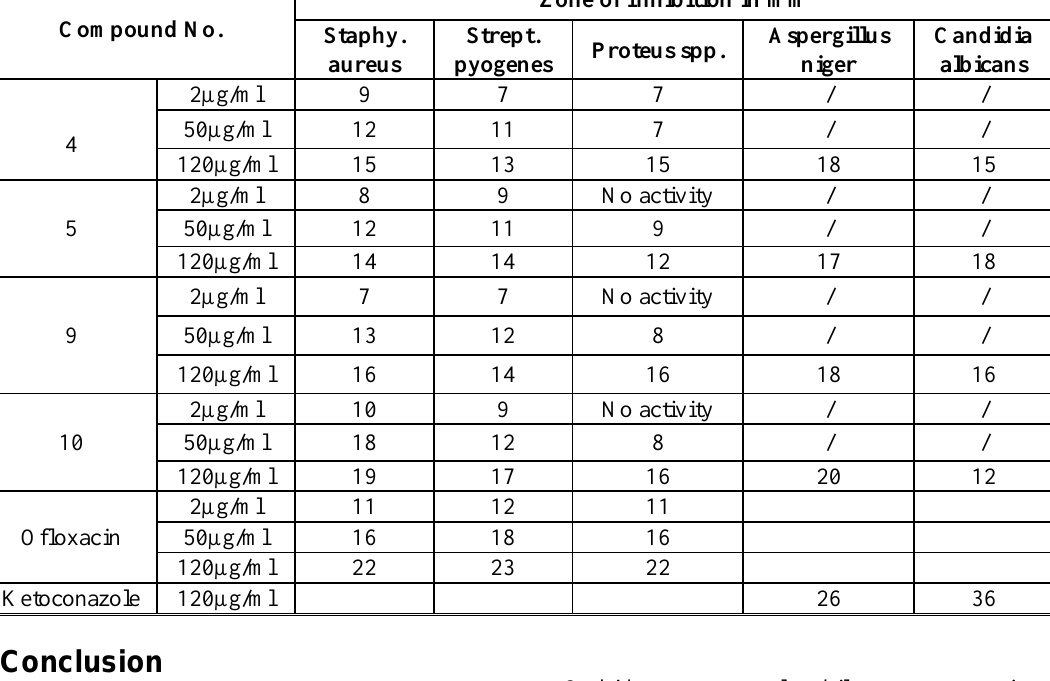
Table 4: Antimicrobial screening data (zone of inhibition in mm) for final compounds Compound